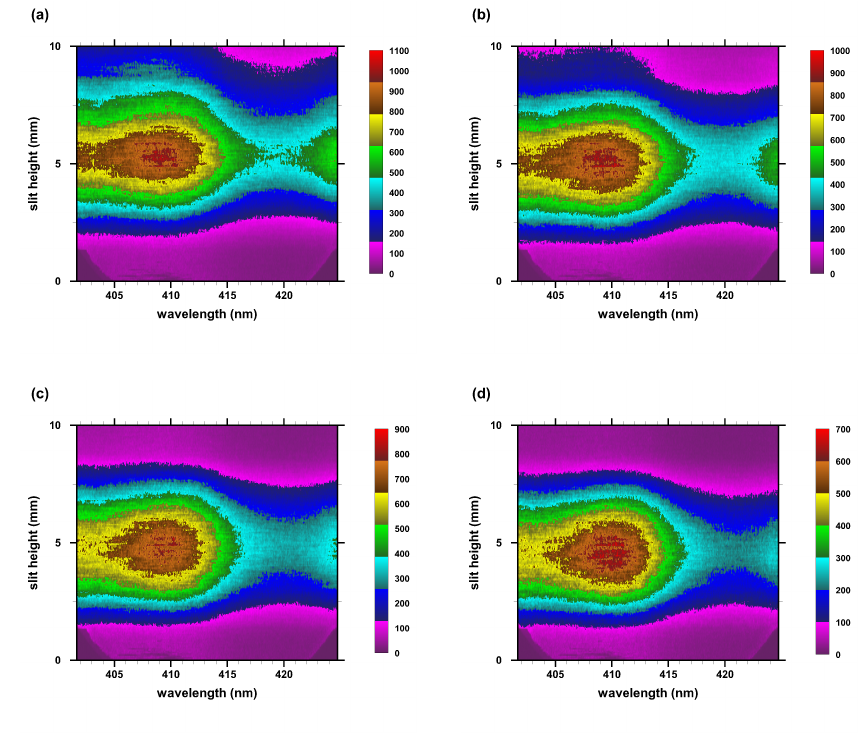
Figure 3. Recorded H δ spectra along the slit for time delay of: ( a ) 100 ns; ( b ) 150 ns; ( c ) 200 ns; and ( d ) 275 ns. The recorded H γ and H δ maps reveal expected variations along the slit dimension. This work reports analysis of the spectra displayed in Figures 2 and 3. Published line shapes [21] are